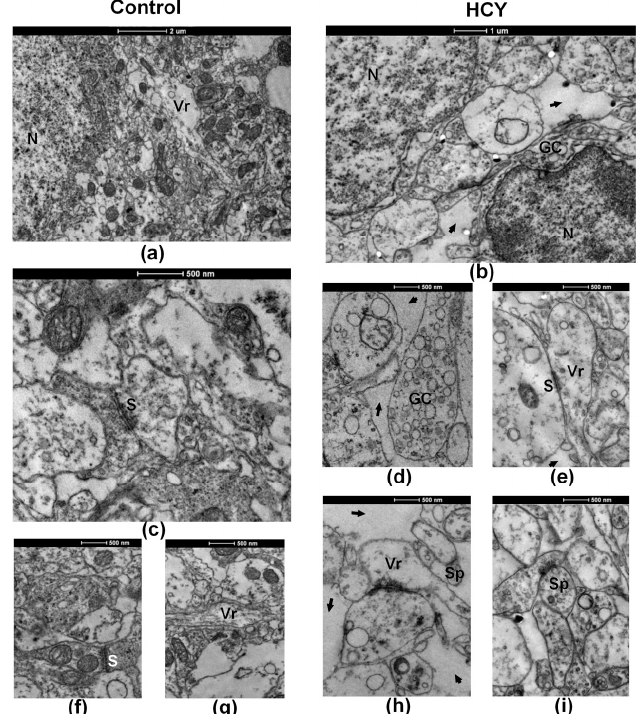
Figure 9. Electron microscope examination of the CA1 region of the dorsal hippocampus of control ( a , c , f , g ) and HCY ( b , d , e , h , i ) rats at P20. Sp—dendritic spines, S—synaptic contacts, Vr—varicose shafts, GC—growth cone, intercellular spaces are marked with arrows. Scale bars: 2 μ m ( a ), 1 μ m ( b ), 500 nm ( c – i ). At P20, both groups showed a small number of varicose extensions on neuronal pro- cesses (Figure 9a, g versus Figure 9e), but unlike control animals, in which varicose exten- sions form mature synaptic contacts with axon terminals, HCY rats had only a few imma- ture synaptic contacts with underdeveloped postsynaptic densities and rare synaptic